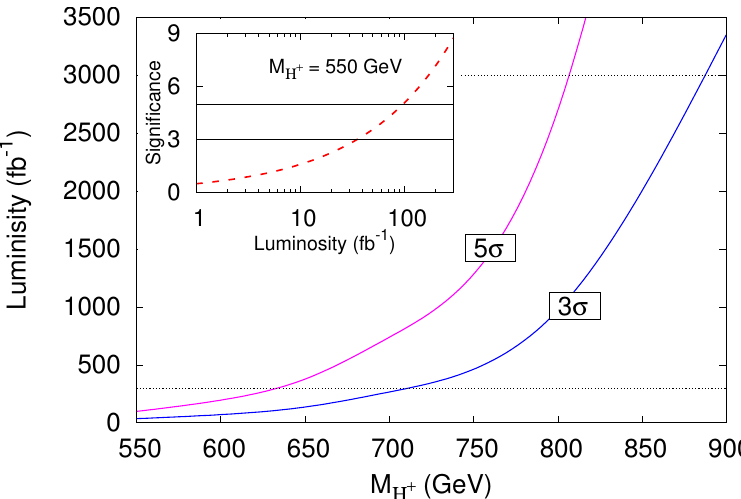
Figure 7 . Projection of 3 (cid:27) (blue) and 5 (cid:27) (magenta) signi(cid:12)cance contours for the opposite-sign charged tracks as a function of HSCP mass and integrated luminosity for the IDM with a RH Majorana neutrino. Inset depicts the signi(cid:12)cance of BP1 with integrated luminosity during 14 TeV runs of LHC.